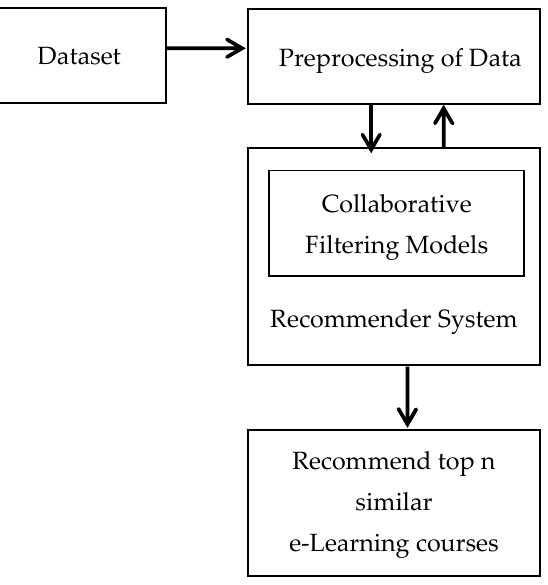
Figure 1. Generic workflow diagram.